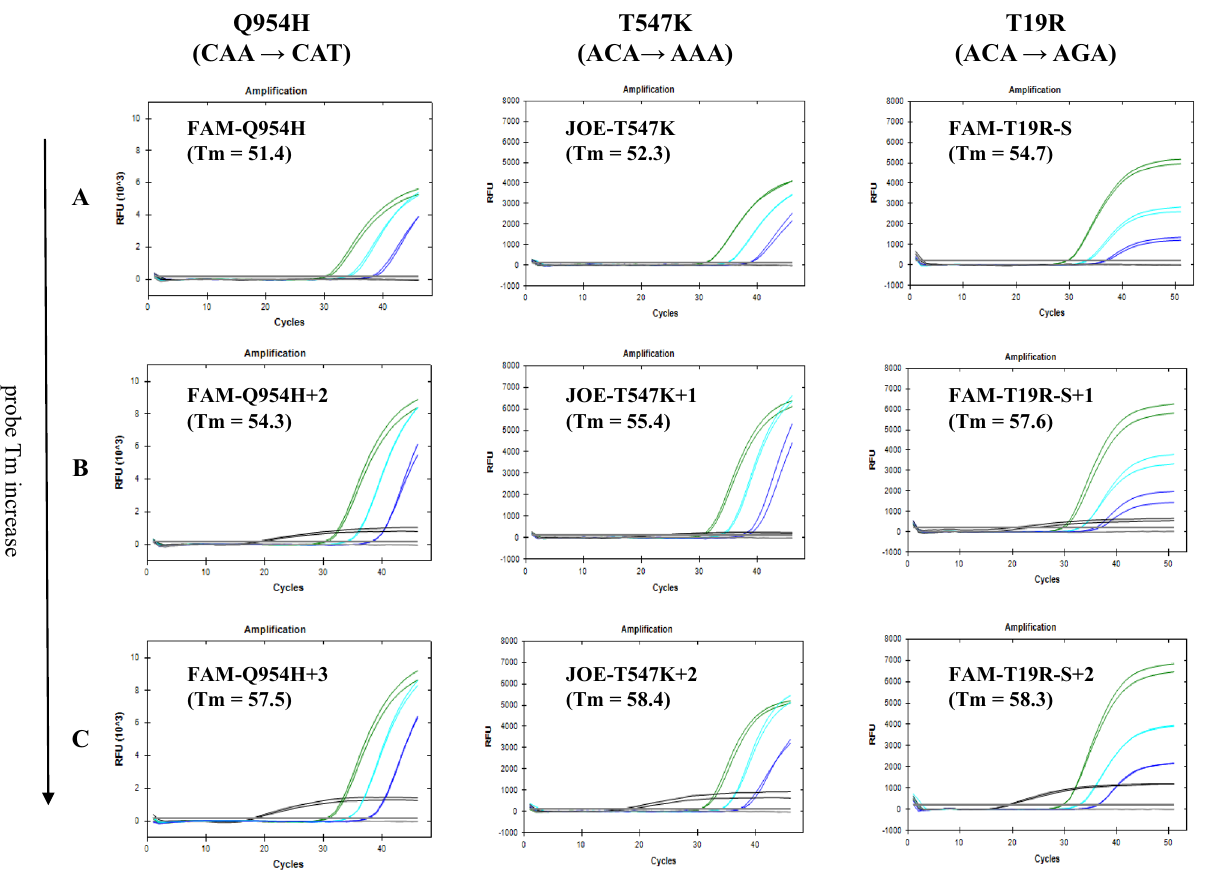
Figure 2. Correlation between probe Tm increase and PCR signal enhancement. Each Probe targets the omicron mutated region Q954H, T547, and Delta mutated region T19R. The Tm of each probe was adjusted by adding one base in the 3’ end per model (( A ): Original template, ( B ): 1 ~ 2 bases added, ( C ): 2 ~ 3 bases added).